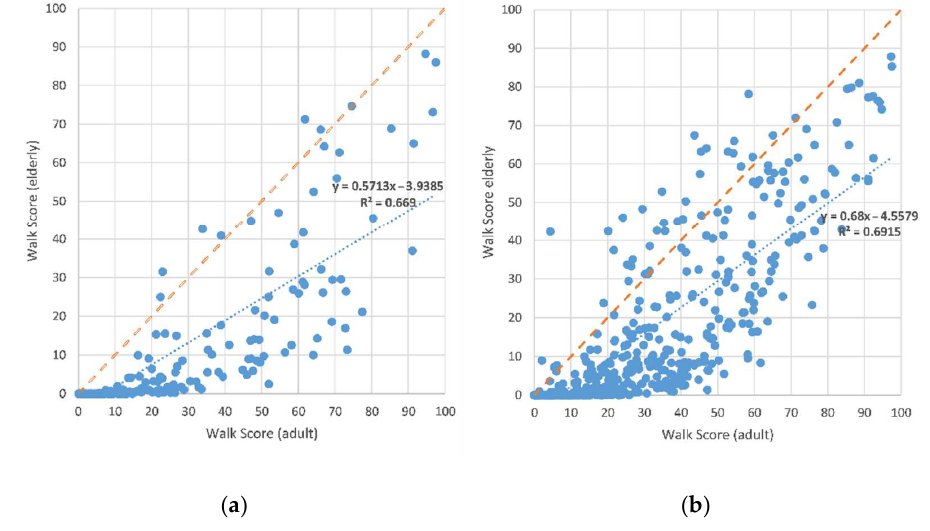
Figure 15. Relationship between standard WS and WS for elderly (HK ( a ), Ostrava ( b )).